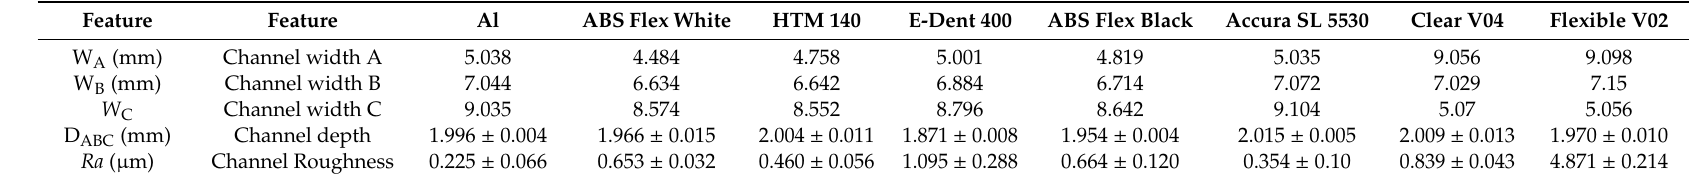
Table 4. Dimensional and surface metrology of main